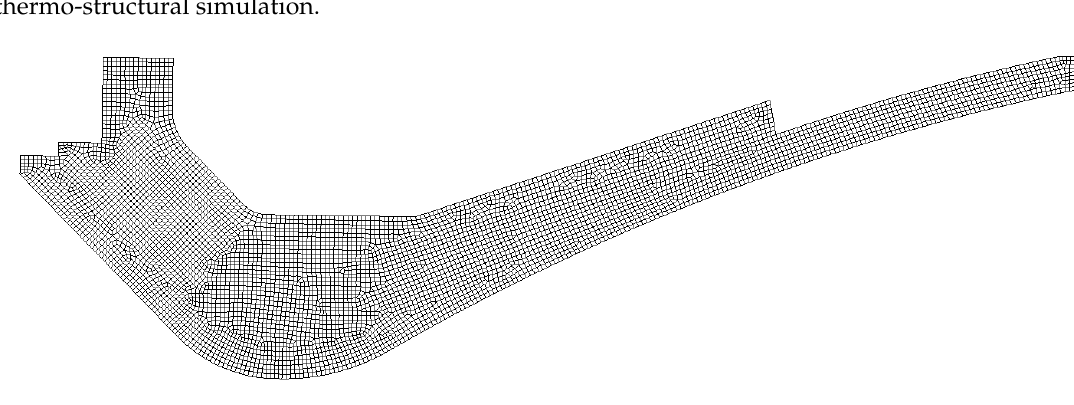
Figure 2. Mesh generation for the thermo ‐ structural simulation.